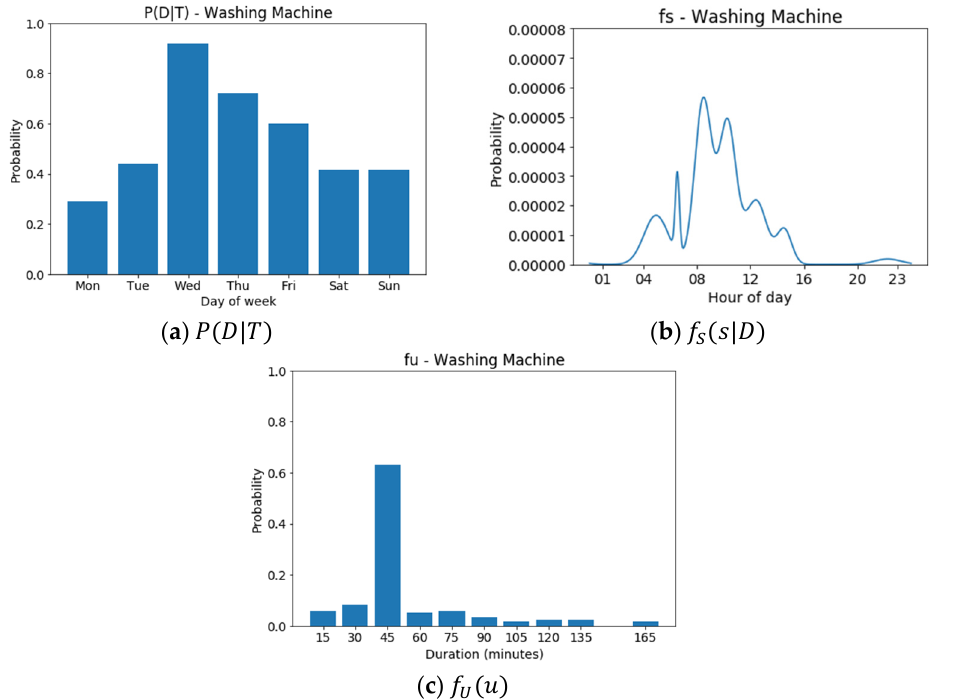
a washing Figure 1. Indicative examples of ( a ) the 𝑃(𝐷|𝑇) , ( b ) the 𝑓 (cid:3020) (𝑠|𝐷) , and ( c ) the 𝑓 (cid:3022) (𝑢) distributions for a washing machine.